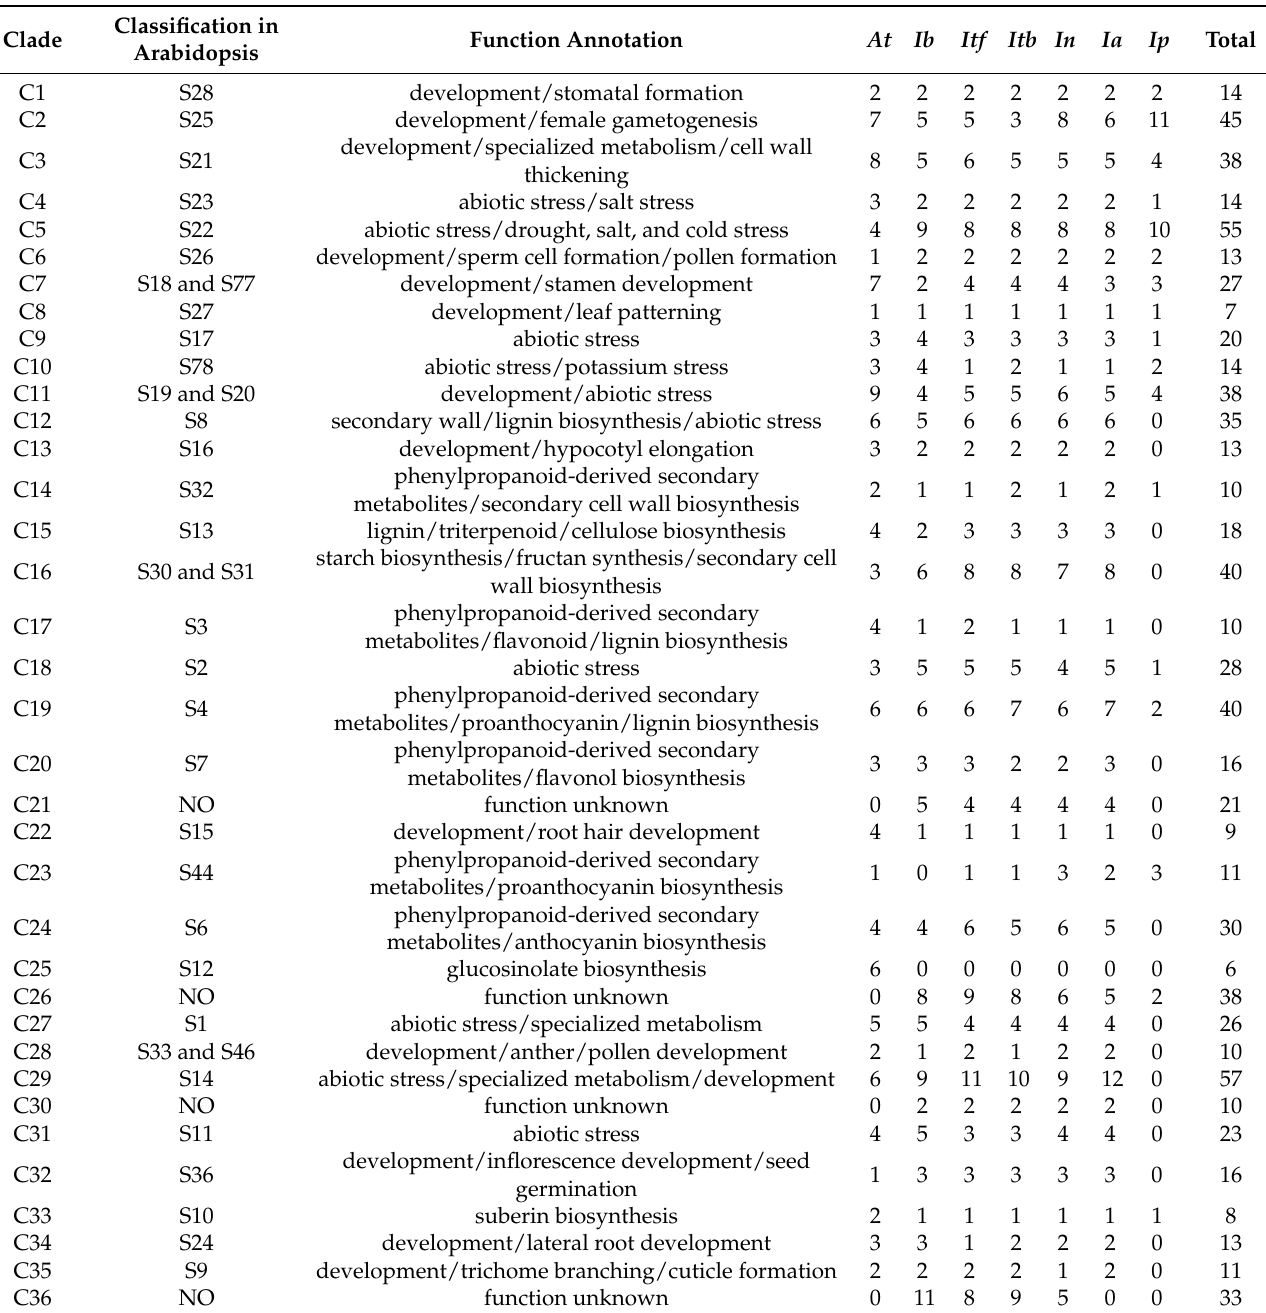
Table 2. The R2R3-MYB members number of each clade in each species and their major functions of each